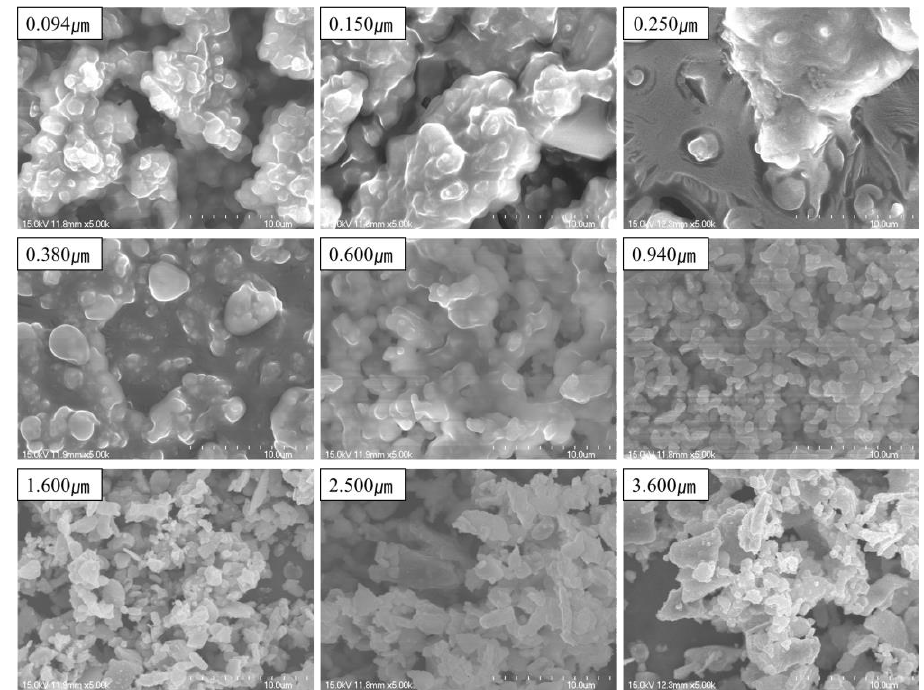
Figure 11. Morphology of PM in subway tunnels according to size at the M station.